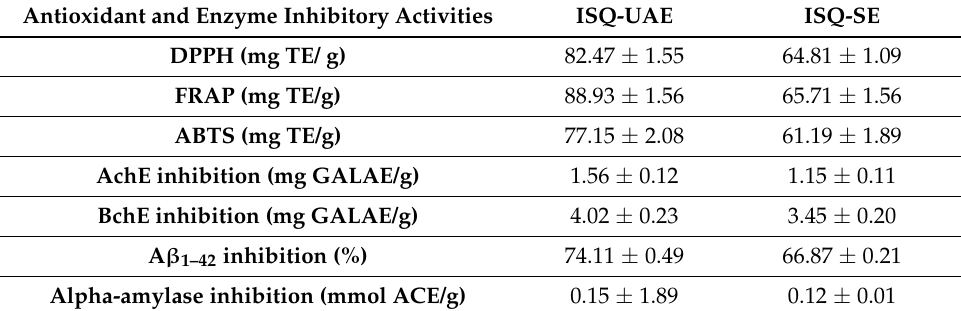
Table 4. Antioxidant and enzyme inhibitory activities of E. alata